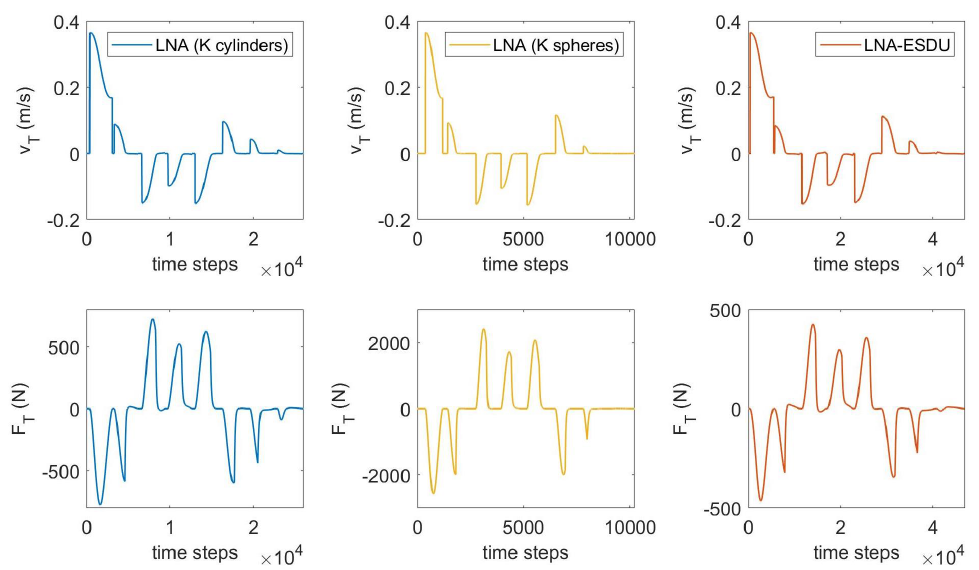
Figure 9. Relative tangential velocity v T and friction force F T in terms of the number of time steps.